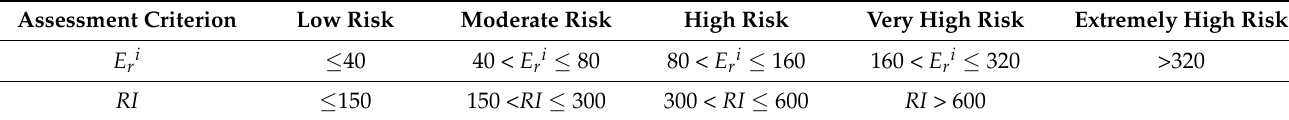
Table 2. Ecological risk classification of